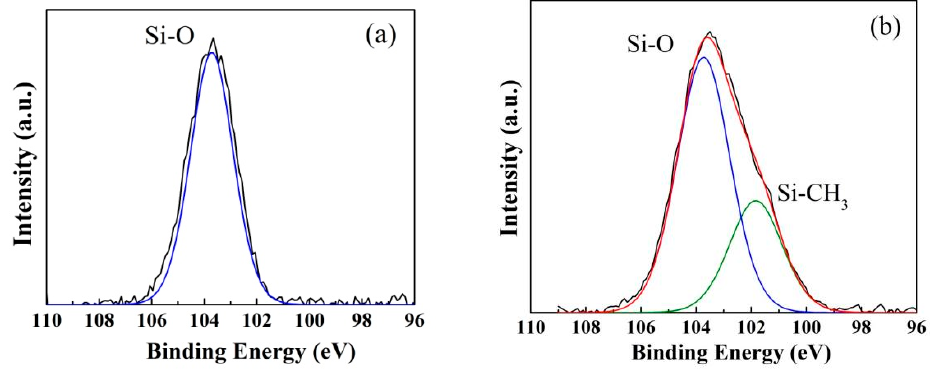
Figure 4. Si 2p spectra of XPS analysis for the (a) hydrophilic and (b) hydrophobic ZrO 2 -SiO 2 xero- gels